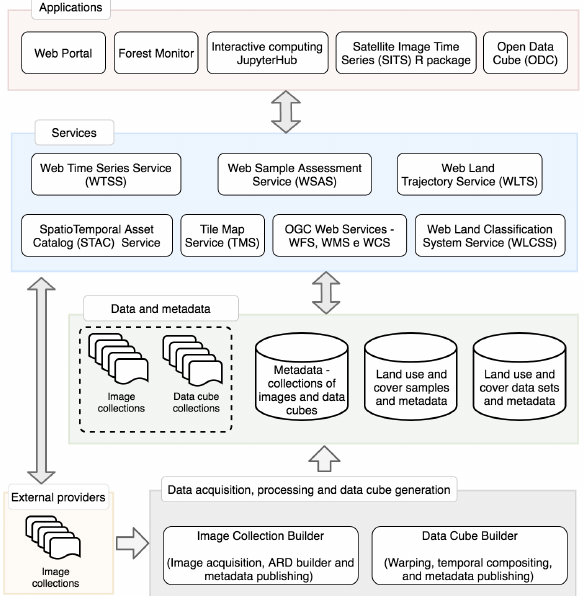
Figure 1. Brazil Data Cube Project: data and software products. Source: (Ferreira et al., 2020)